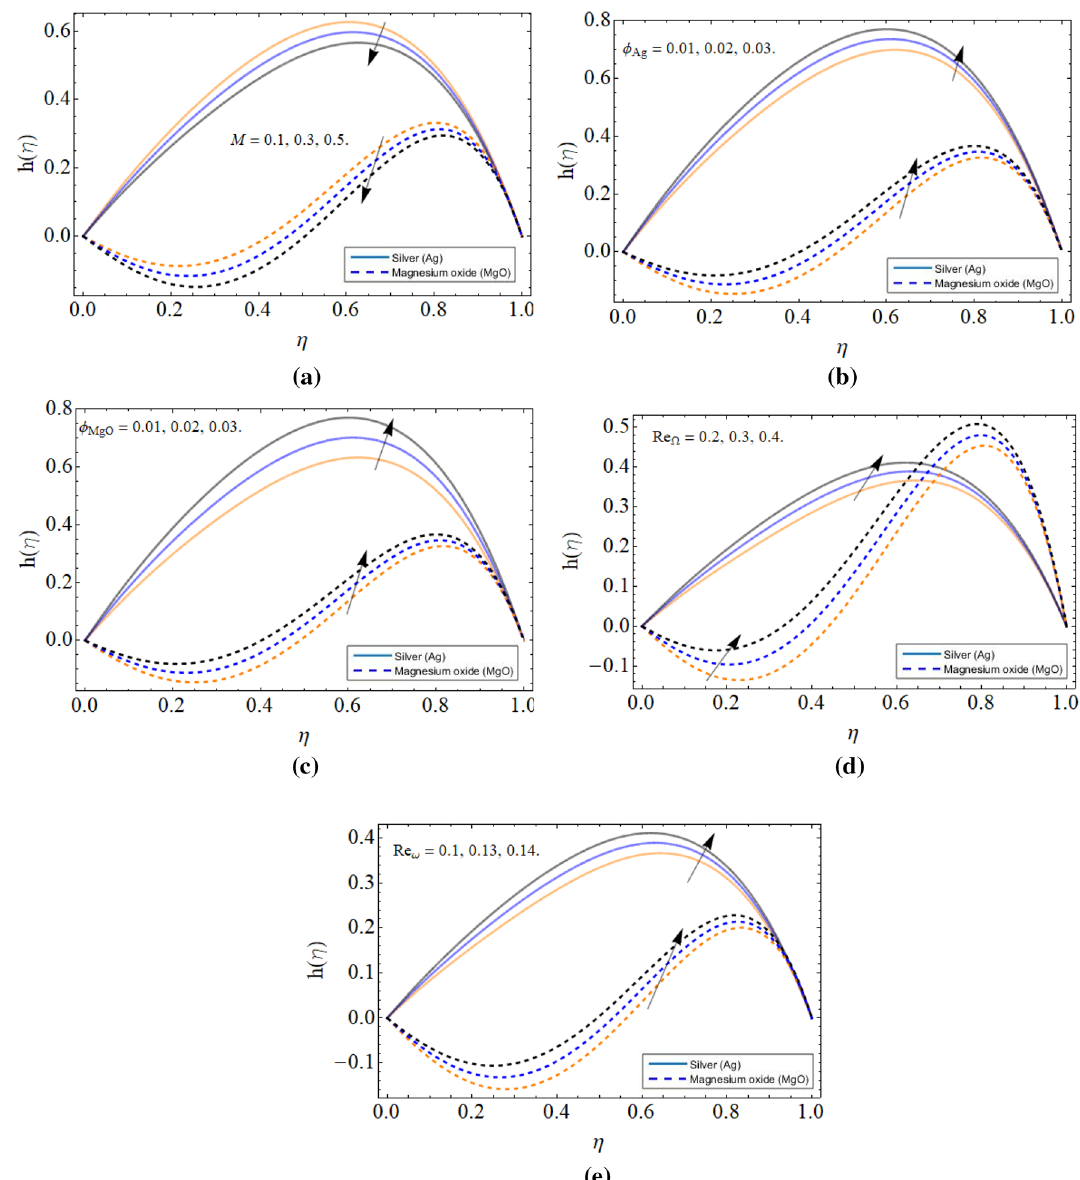
Figure 4. The behavior of tangential velocity profile h (η) versus ( a ) magnetic field M ( b ) volume friction of silver φ Ag ( c ) volume friction of magnesium oxide φ MgO ( d ) cone angular velocity Re (cid:31) ( e ) disk angular velocity Re ω